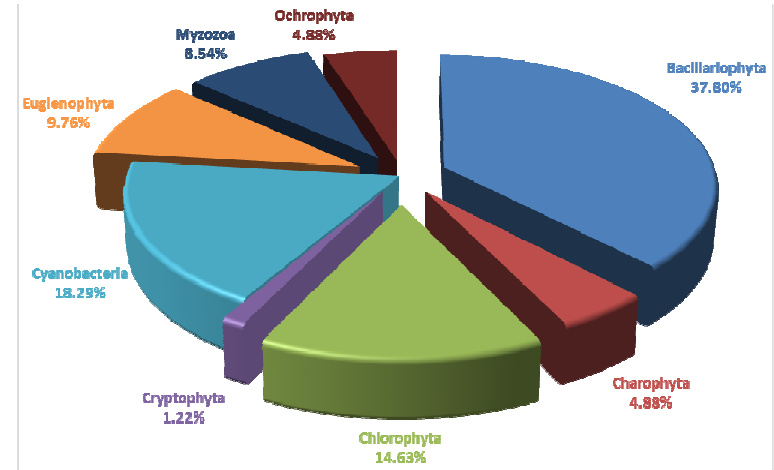
Fig. 2. Percentage composition of recorded phytoplankton